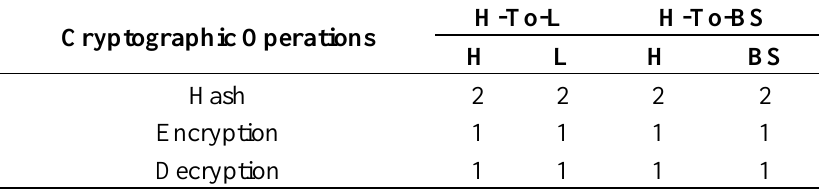
Table 3. Computation cost for H-To-L and H-To-BS link operations.